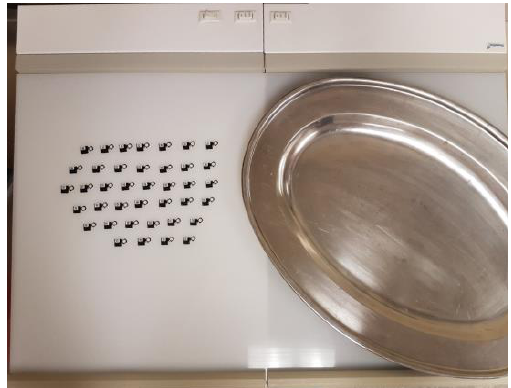
Figure 6. X-ray lightbox. Optical annealing set up with an array of 40 open OSLDs arranged on the surface of an X-ray lightbox. surface of an X-ray